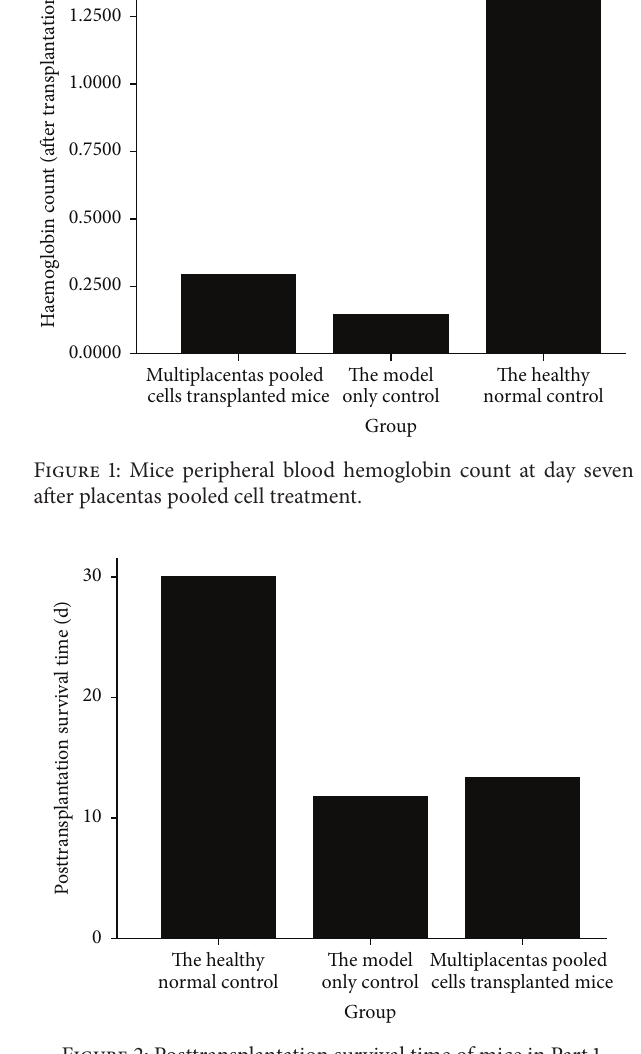
Figure 2: Posttransplantation survival time of mice in Part